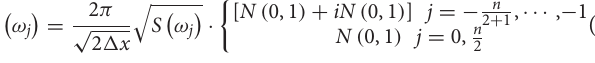
FIGURE 3 | Magnetic induced relative roughness Ra r . (A) Relationship with initial roughness. (B) Relationship with particle volume